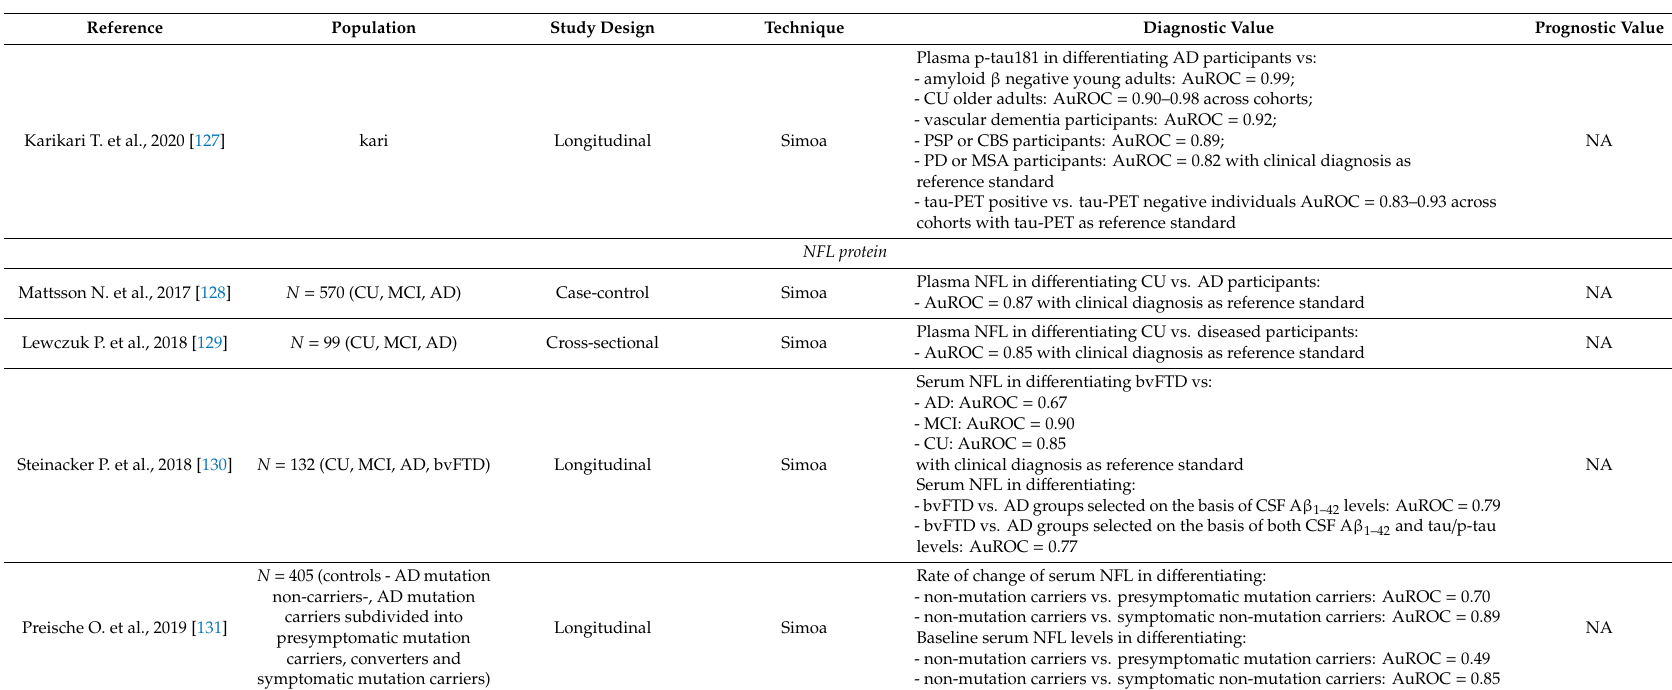
Abbreviations : AD: Alzheimer’s disease; AuROC: area under the receiver operating curve; A β : amyloid β ; A β 1–40 : amyloid β -peptide 1–40; A β 1–42 : amyloid β -peptide 1–42; bvFTD: behavioral variant frontotemporal dementia; CBS: corticobasal syndrome; CSF: cerebrospinal fluid; CU: cognitively unimpaired; ECLIA: electrochemiluminescence immunoassay; FTD: frontotemporal dementia; FTLD: frontotemporal lobar degeneration; HR: hazard ratio; IMR: immunomagnetic reduction; IP: immunoprecipitation; IP MS: immunoprecipitation coupled to mass spectrometry; MCI: mild cognitive impairment; MDS: multimer detection system; MS: mass spectrometry; MSA: multiple system atrophy; NA: not assessed; NFL: neurofilament light chain; nfvPPA: non-fluent variant primary progressive aphasia; PD: Parkinson’s disease; PPA: primary progressive aphasia; PSP: progressive supranuclear palsy; p-tau181: phospho-tau181; Simoa: single molecule array; SMC: subjective memory complainers; svPPA: semantic variant primary progressive aphasia; t-tau: total-tau; xMAP: multi-analyte